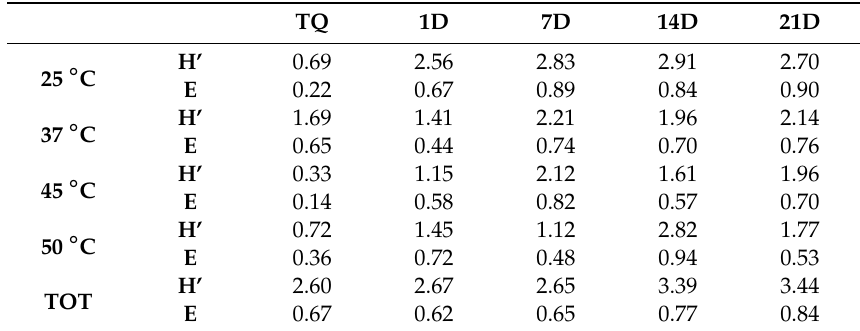
Table 3. Shannon’s biodiversity index (H’) and evenness (E) of analyzed samples detailed at di ff erent temperatures, and cumulative samples (TOT).